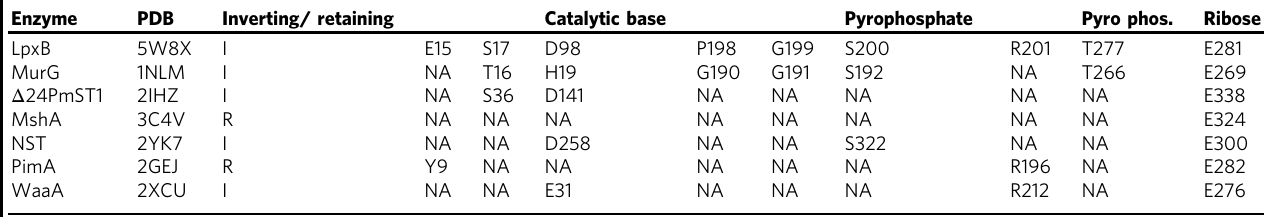
Table 3 Comparison of GT-B active sites